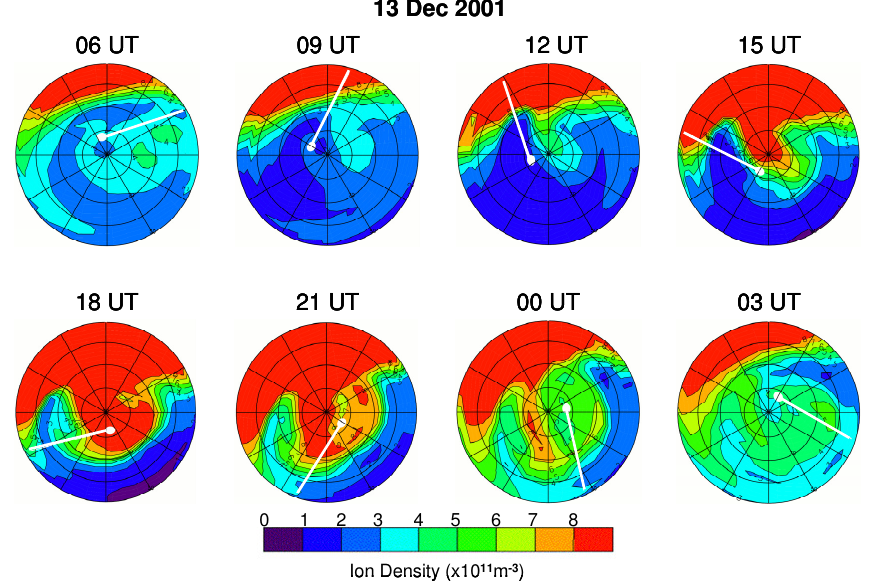
Fig. 4. Ion densities modelled by CTIP for 13 December 2001. The panels are at 3-h intervals of UT, with each panel showing the ion density distribution at an altitude of 320km, near the F-region ionisation peak, as a function of MLAT and MLT. Magnetic latitude extends from 50 ◦ MLAT at the outer circumference to the magnetic pole in the centre of the circle. Magnetic noon is at the top of each panel with midnight at the bottom, 18:00MLT is on the left-hand side and 06:00MLT on the right-hand side. The small white region near the centre encompasses the geographic pole, and the white line shows the 18 ◦ E meridian near the longitude of the Scandinavian tomography chain.